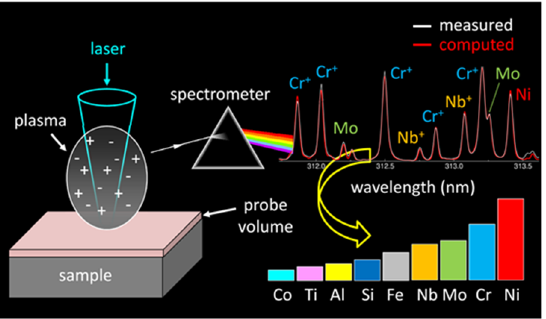
Figure 15. Schematic of elemental analysis via calibration-free Laser-Induced Breakdown Spectros- copy (LIBS).